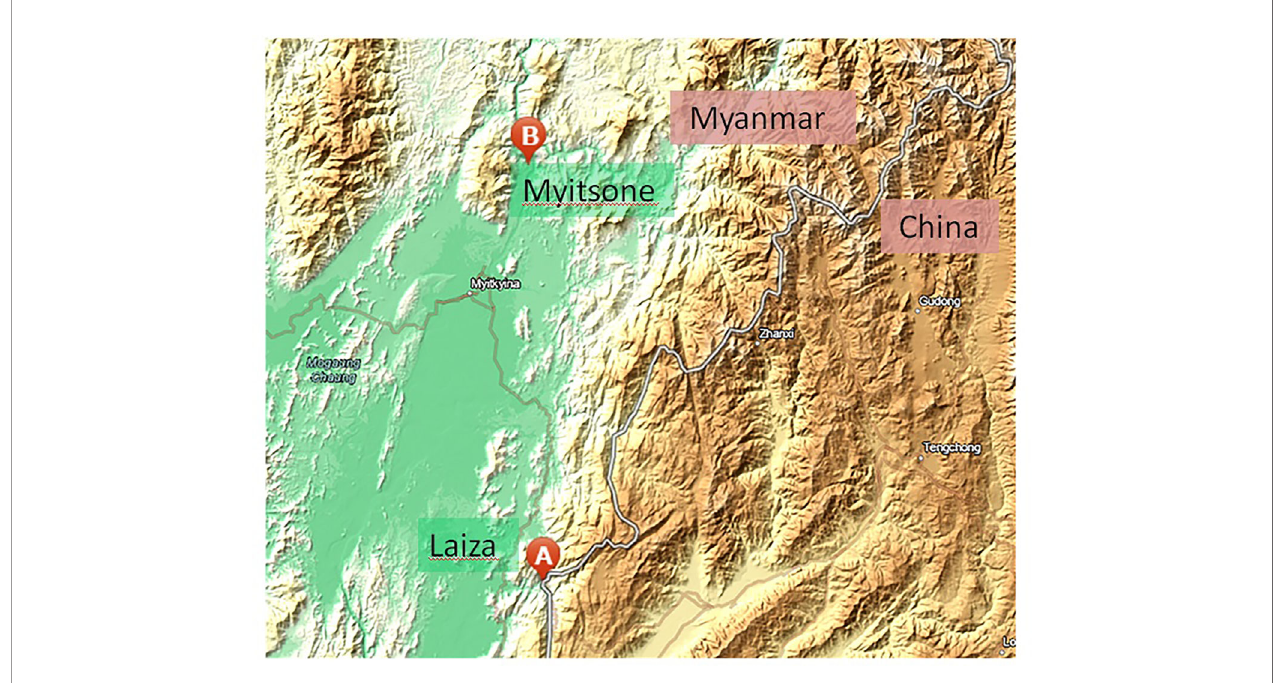
FIGURE 1 | Map of sampling